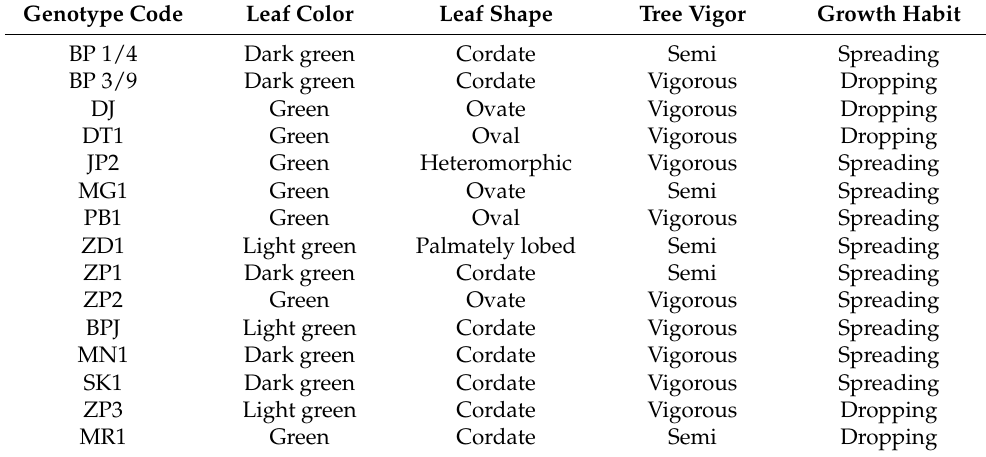
Table 2. Tree and leaf qualitative characteristics of mulberry